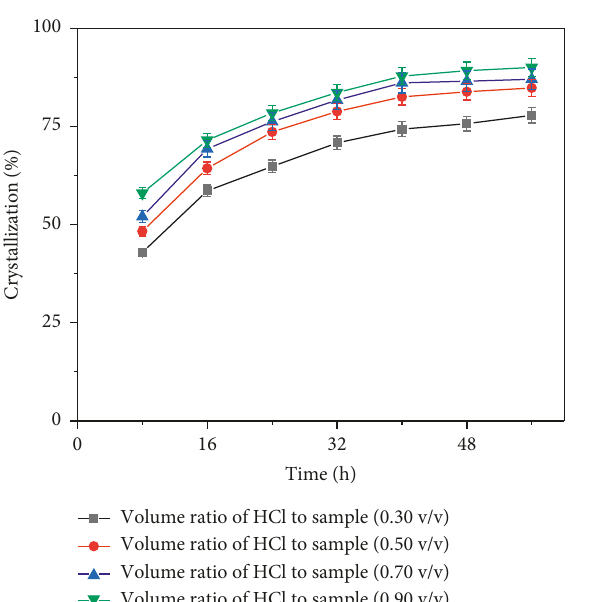
Figure 8: Effect of the volume ratio of concentrated hydrochloric acid to the samples from 0.30 to 0.90 (v/v) and time from 8 to 56h on aluminum chloride hexahydrate crystallization at 25 °